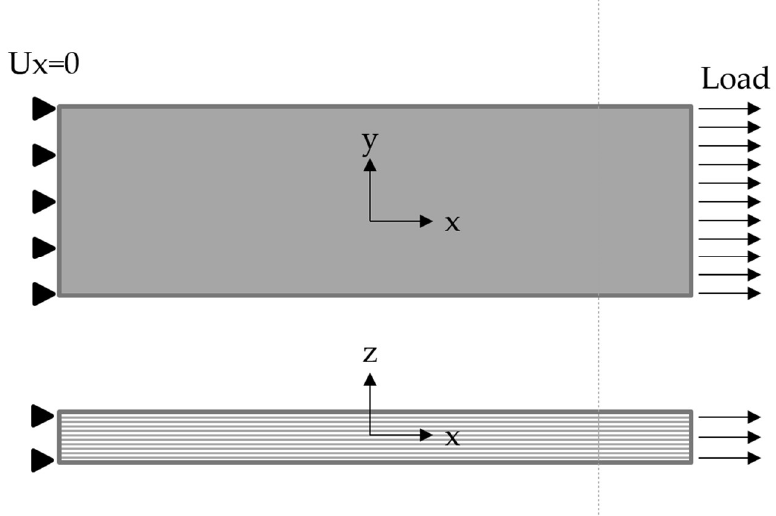
Figure 7. S-N curves used for verification of the FDM [29]: ( a ) UD 10°, ( b ) UD 15°, ( c ) UD 30°.